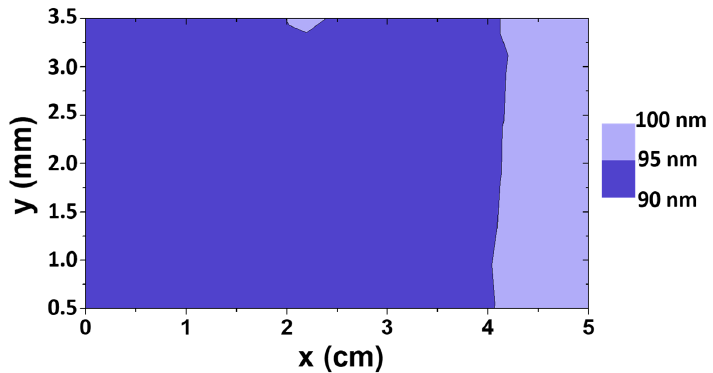
Figure 5. Colored ‐ coded thickness map of a typical 5 cm length SDP ‐ Y 2 O 3 sample. The averaged thickness fluctuates between 90 nm and 100 nm. Measurements were taken each cm in the longitudinal direction and three measurements were acquired in the transversal direction. The diameter of the reflectometer’s spot is 1 mm. Edges were avoided in the reflectometric measurements.